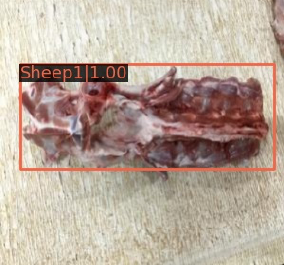
Figure 11. The Recall and AP of mutton parts based on Swin-T mutton multi-parts classification detection model.